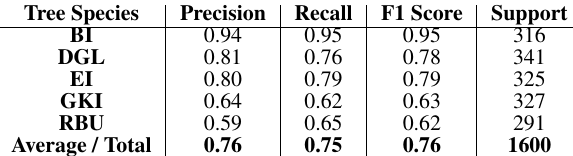
Table 2. Precision, recall, F1 score and support for CNN classification without image scaling.